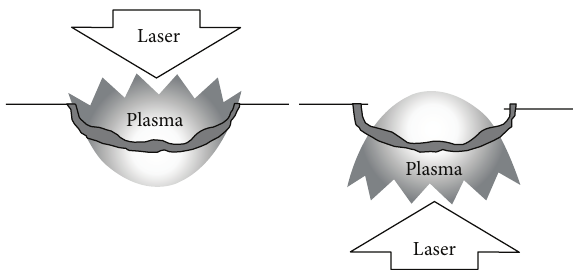
Figure 6: Schematic illustration of the damage-plasma interaction with surface material during front and rear surface irradiation